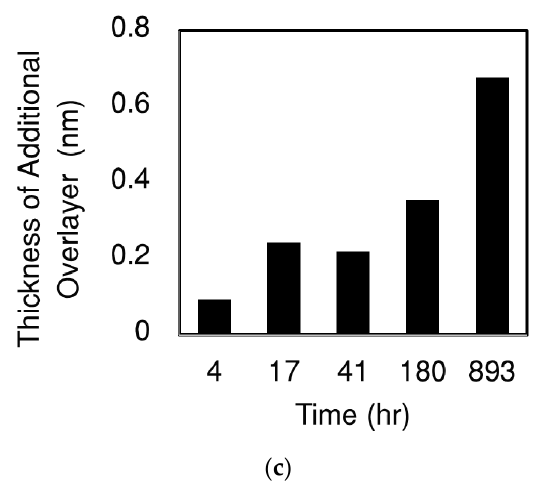
Figure 5. SPRi results of ( a ) sample 2 and ( b ) sample 4 ( the inner plots show the angle-scanning result and the outer curve shows the effect of adsorbed VOCs on the SPR signal at 44.8°), and ( c ) XPS result of sample 2 shows the trend of adsorbed VOCs layer thickness variation.